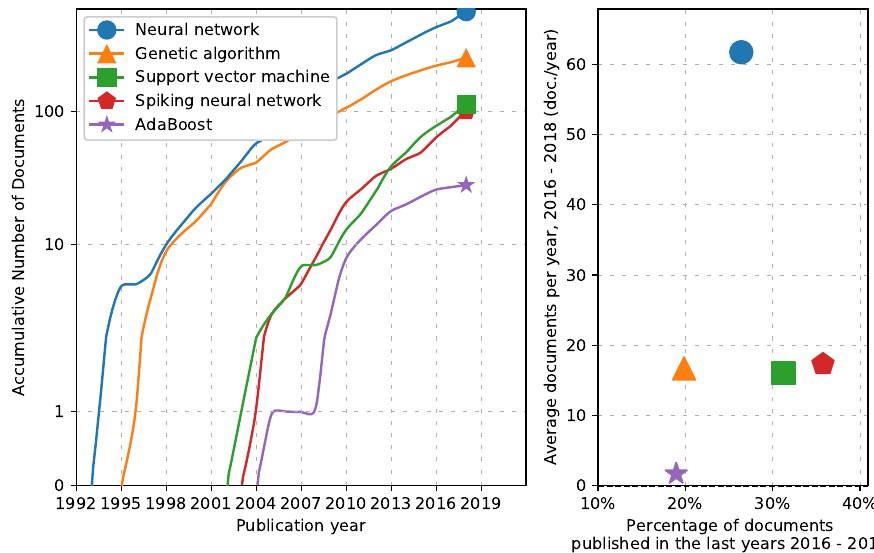
Figure 9. Machine learning top implementations in FPGA